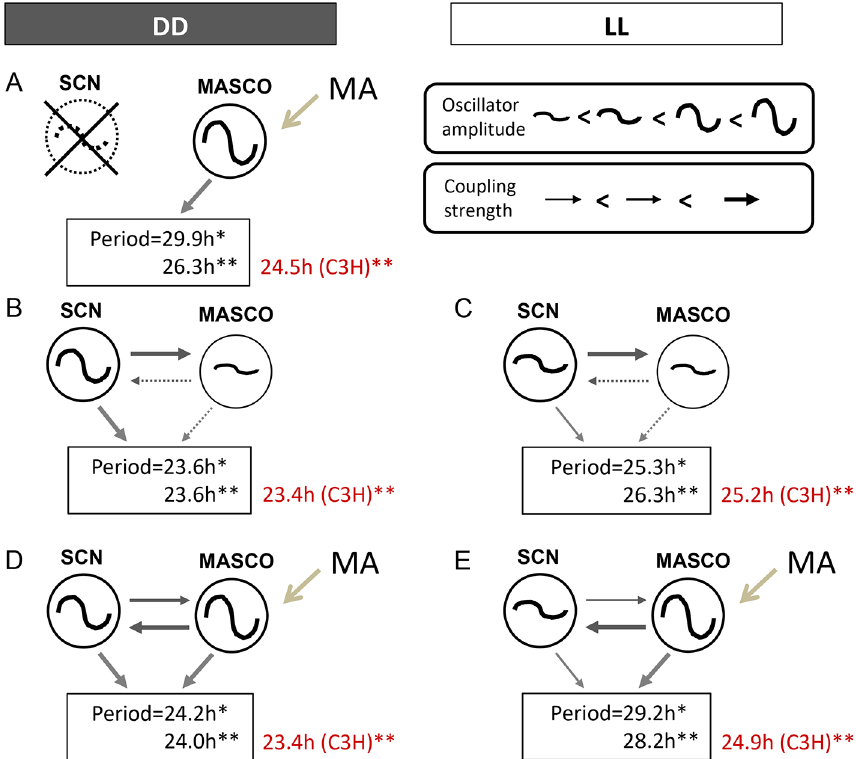
Figure 2. Current model of SCN-MASCO coupling in C57BL/6J mice. The effects of short-term methamphetamine administration on periods of activity rhythms in C57BL/6J (black font) and C3H (red font) mice are shown. Black arrowsindicatecouplingbetweenoscillators.Grayarrowsindicatestrengthofoutput.*DatatakenfromPendergast et al . 2013. **Data taken from Tataroglu et al . 2006. See Table 1 for other studies. Figure modified from Yamazaki 2019 56 with